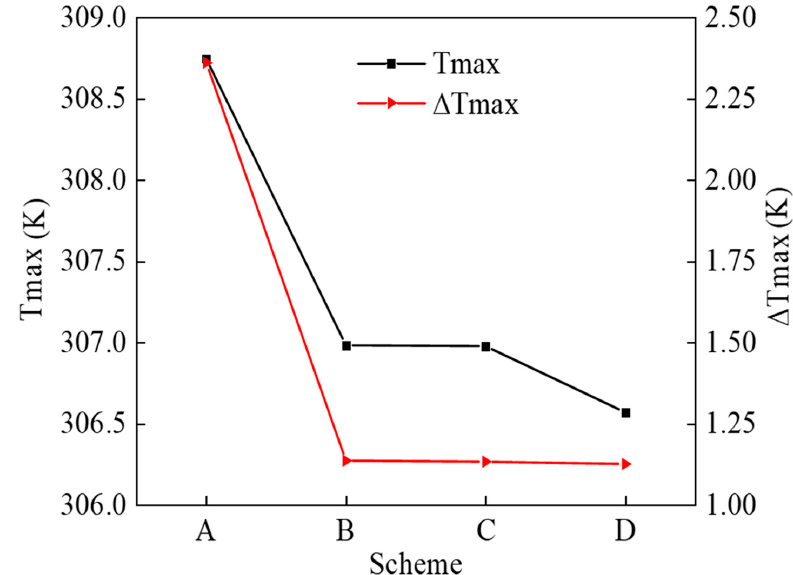
Figure 8. Tmax and ∆ Tmax under different schemes.